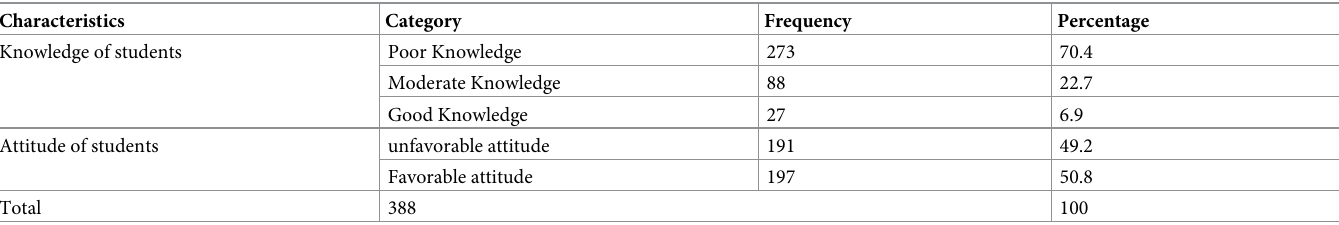
Table 2. The overall level of knowledge and attitude towards COVID-19 among Jimma high school students 2021/ (n = 388).